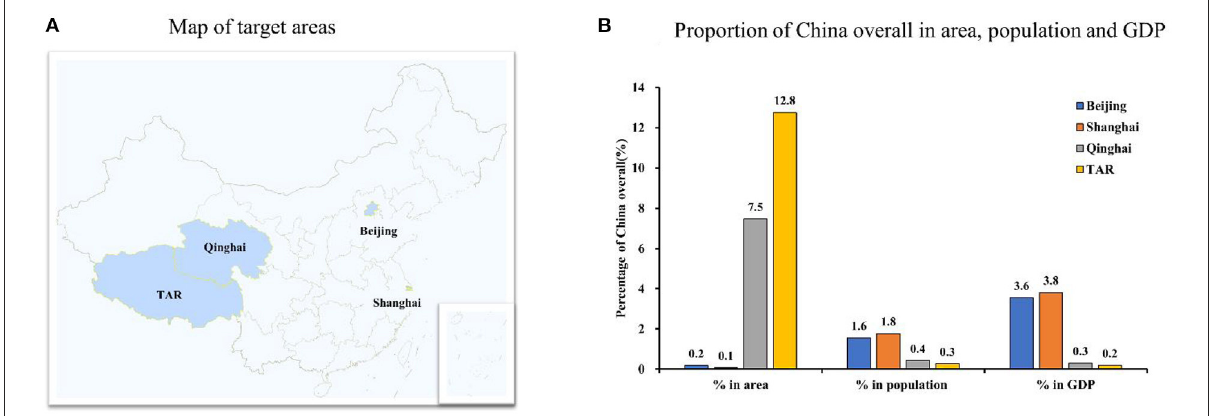
FIGURE1 Comparison of Beijing, Shanghai, Qinghai and Tibetan Autonomous Region in geographic location, area, population and GDP in 2021. TAR, Tibet Autonomous Region; GDP, Gross Domestic Products. (A) Map of target areas. (B) Proportion of China overall in area, population and GDP. Data were from the Statistical Yearbook of China